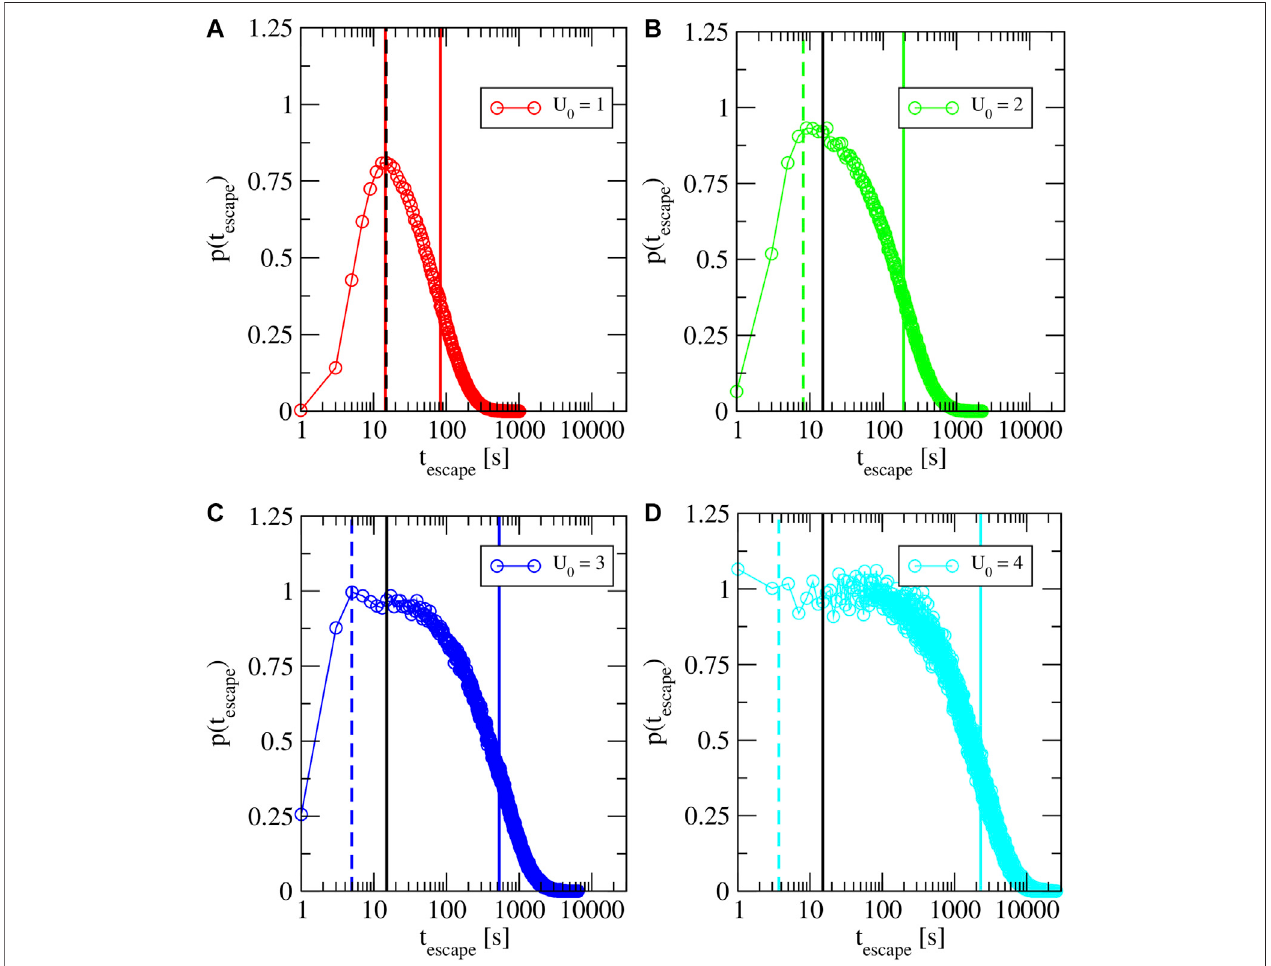
FIGURE 14 | (Color online) Normalized histograms of the escape times obtained from the random walker simulations. The data are labeled according to the target Brownian dynamics simulations displayed in Figure 10 . Vertical blue, green, and red dashed lines represent the mean time t # required by the random walker to reach one boundary of a periodic cell of size L #, given that the random walk started at any point inside the periodic cell. Vertical blue, green, and red continuous solid lines are associated to the mean value of the escape time in the random walker model. The vertical black continuous solid line indicates the average critical time t * obtained from the Brownian dynamics